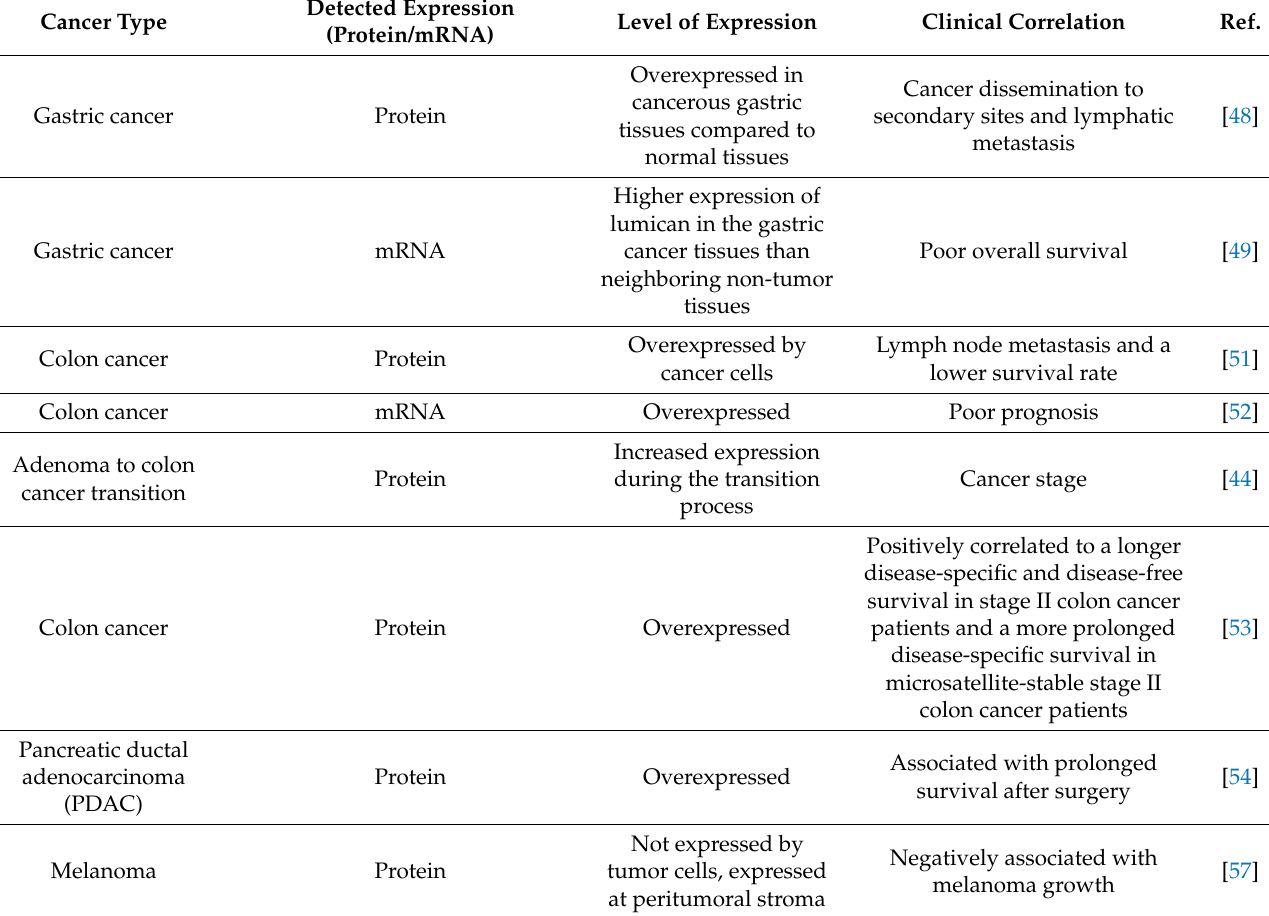
Table 1. Lumican expression in tumor tissues and correlation to